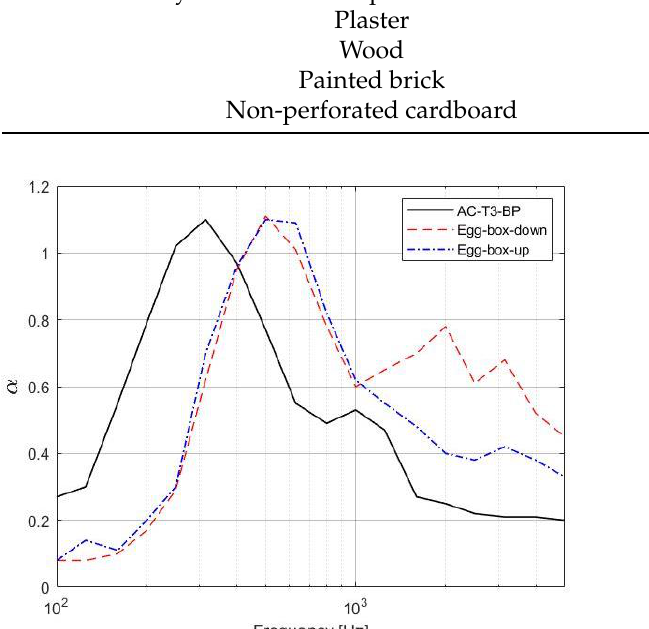
Figure 11. Comparison of the sound absorption coefficient α measured for panel AC-T3-BP and for egg boxes [25] similar to those employed in this study. In configuration Egg-box-down , the flat surface of the box is in contact with the reverberation room floor.